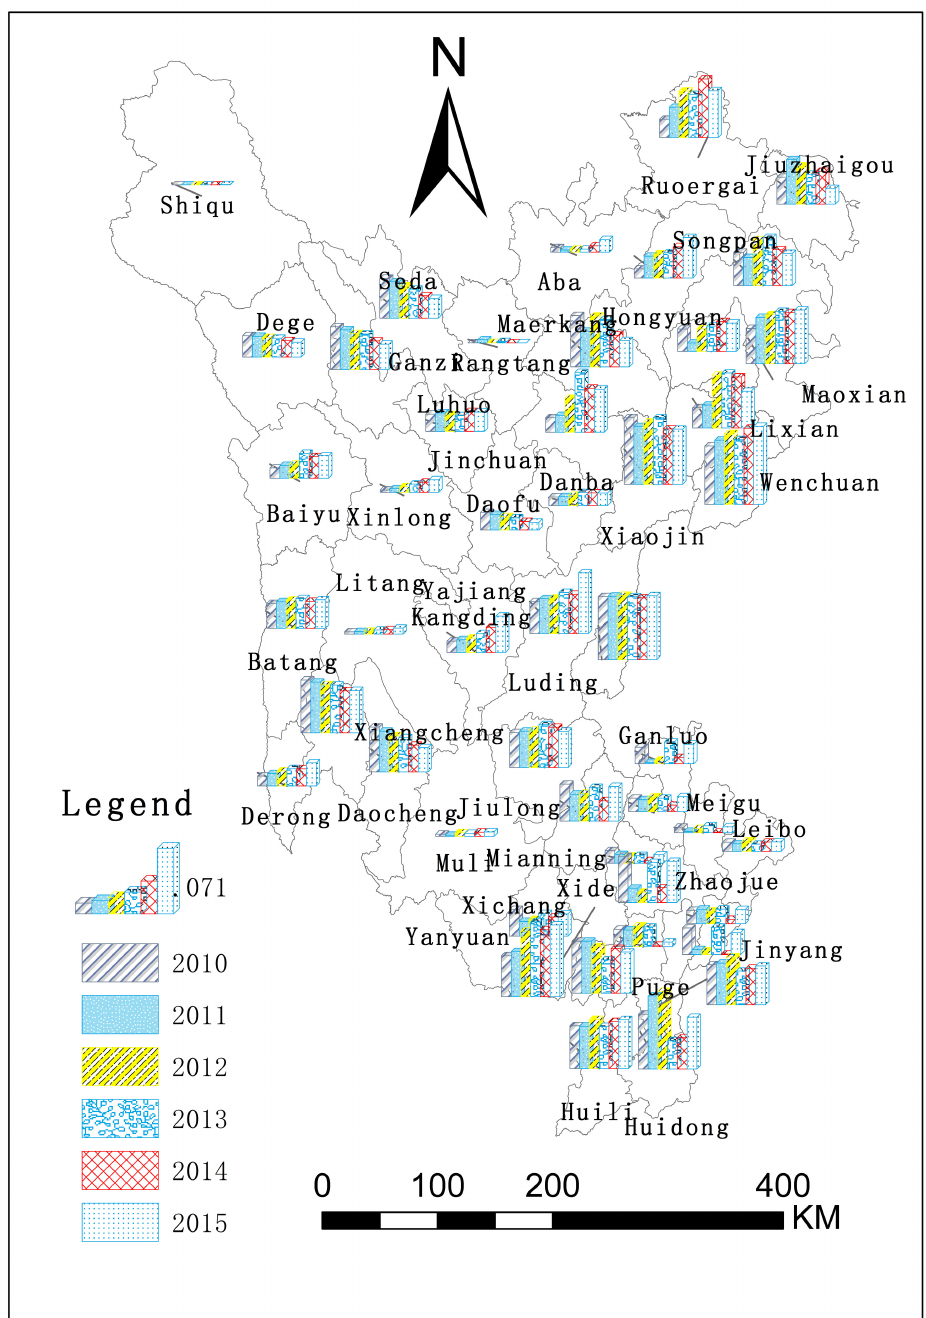
Figure 8. Social capital